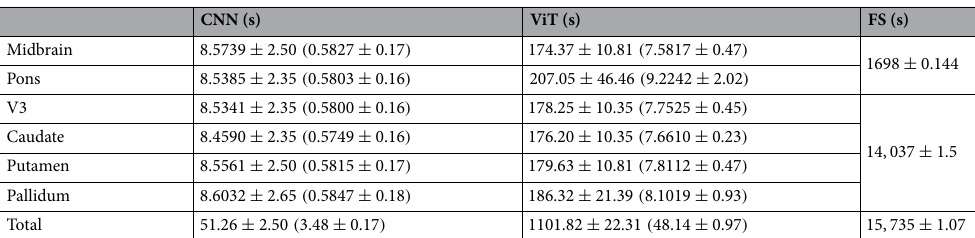
Table 1. Measured segmentation time per patient obtained by using CNN-based V-Net, ViT-based UNETR, and FS using CPU. GPU running time is shown in the (). The time was calculated after the skull-stripped image was obtained. Data are shown as mean ± standard deviation. (V3, third